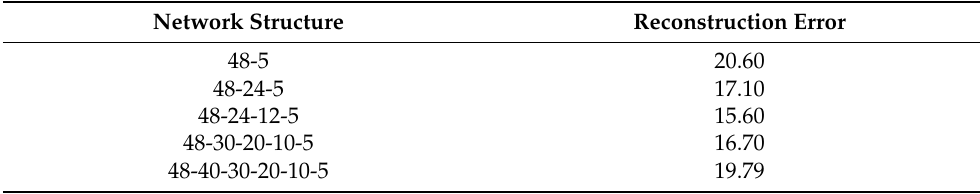
Table 2. Reconstruction error of DAE at different